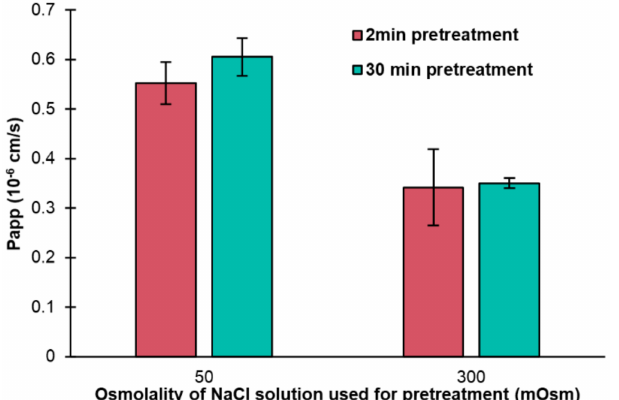
Figure 3. Permeation of calcein across PermeaPad ® in 300 mOsm PBS after 2 or 30 min pretreatment of the barrier with NaCl solutions at 50 (hypo-osmotic) or 300 (iso-osmotic) mOsm. Mean ± SD ( n =